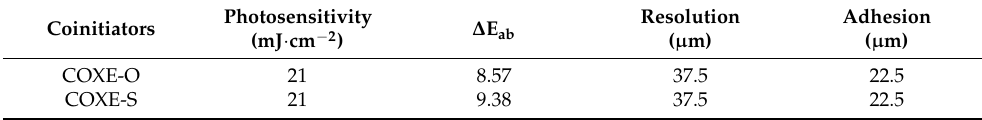
Figure 13. Optical microscopy images of the photolithographic patterns formed via the exposure and development of the DFRs using COXE-O and COXE-S as coinitiators. The resolution test for ( a1 ) COXE-O and ( b1 ) COXE- S, with a “L/S” of 400/37.5 μm. The adhesion test for (a2) COXE-O and (b2) COXE- S, with a “L/S” of 22.5/400 μm. Table 5. The performance data for DFRs used COXE-O and COXE-S as coinitiators (ST = 20/41).